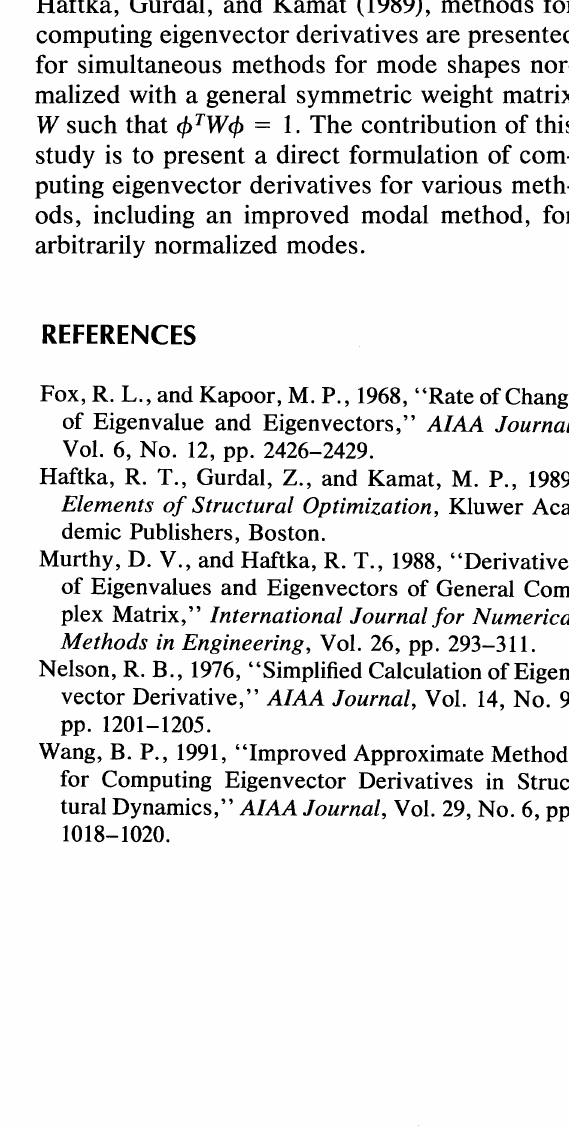
Table 4. Comparison of Eigenvectors for IX - 0.1